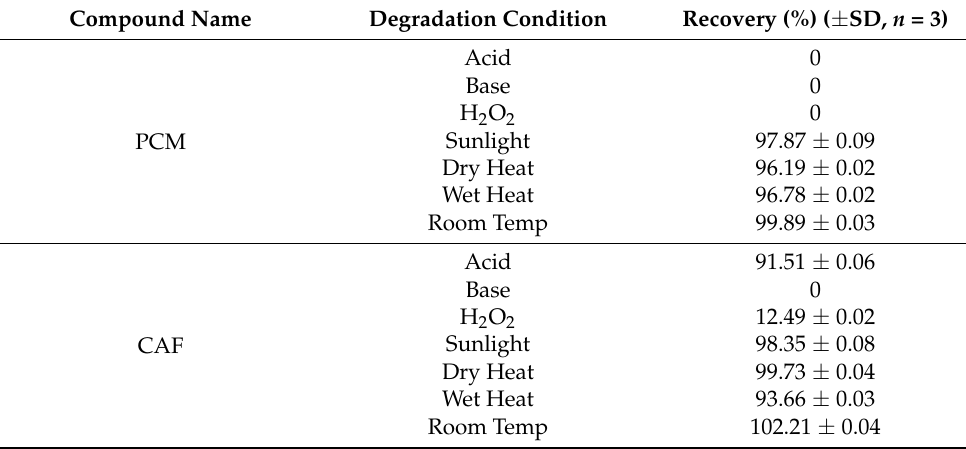
Table 6. Results for stress degradation studies of PCM and